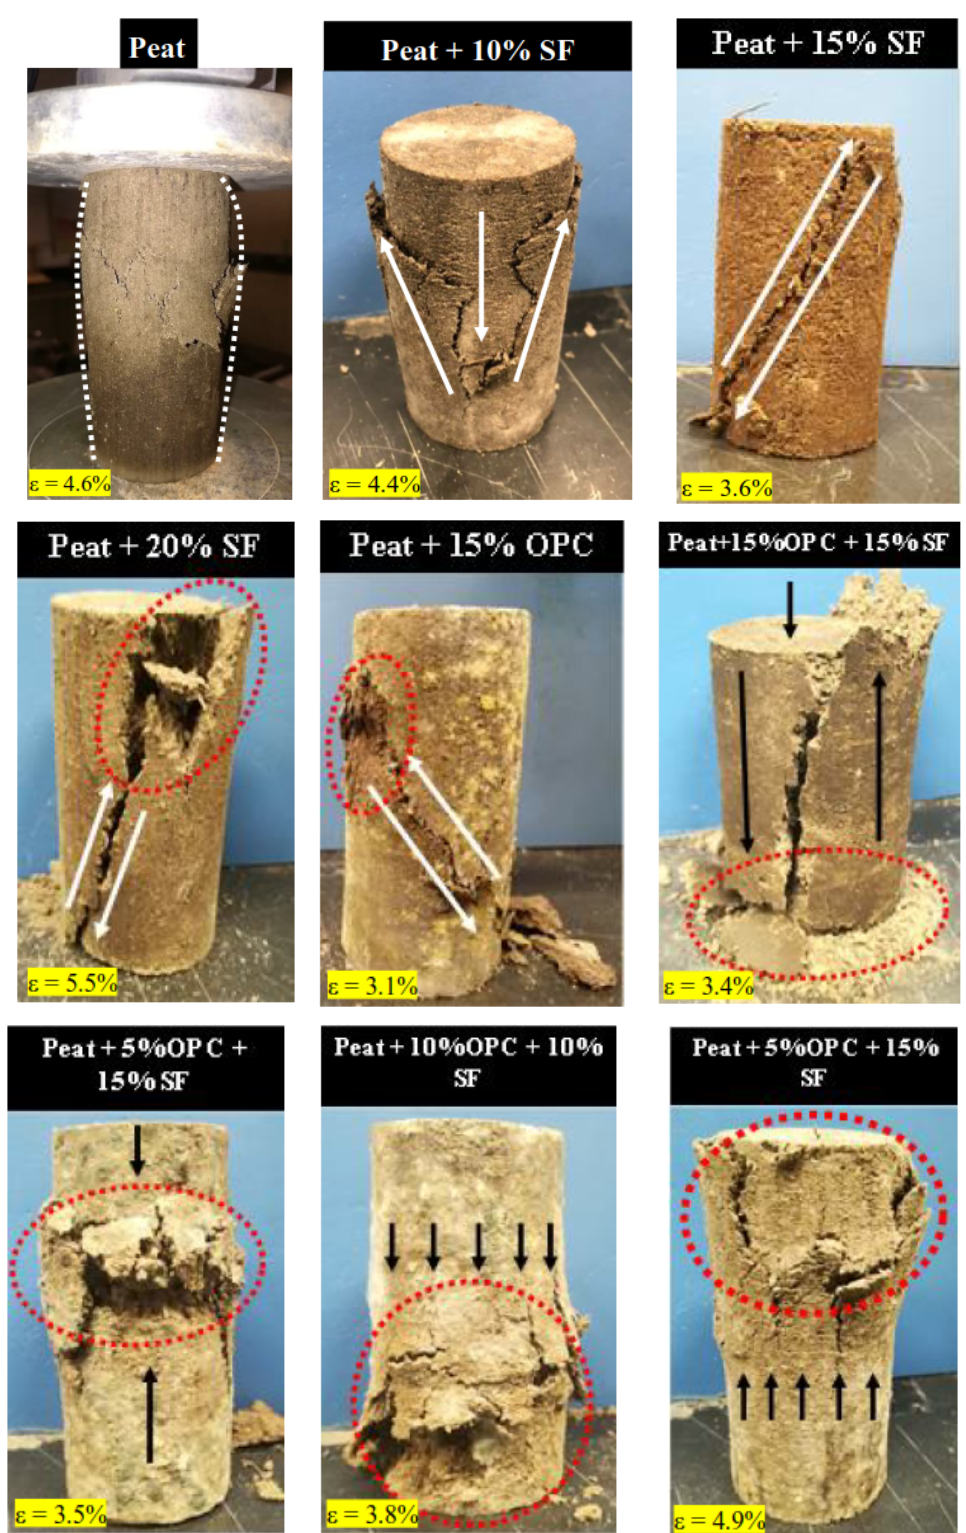
Figure 8. Failure modes of the stabilized and parent peat.